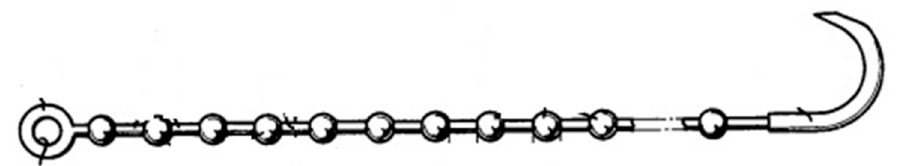
Figure 3. Taichiro Akiyama’s design of a knotless suture with molded spherical projections [17].